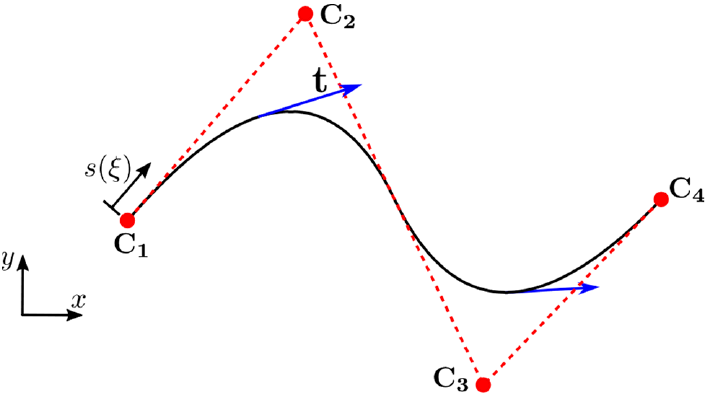
Figure 3. A NURBS curve showing control points ( C 1 , C 2 , C 3 , C 4 ) and tangent vectors t . p = 2; Ξ = { 0,0,0,0.5,1,1,1 } ; all weights are equal to 1.